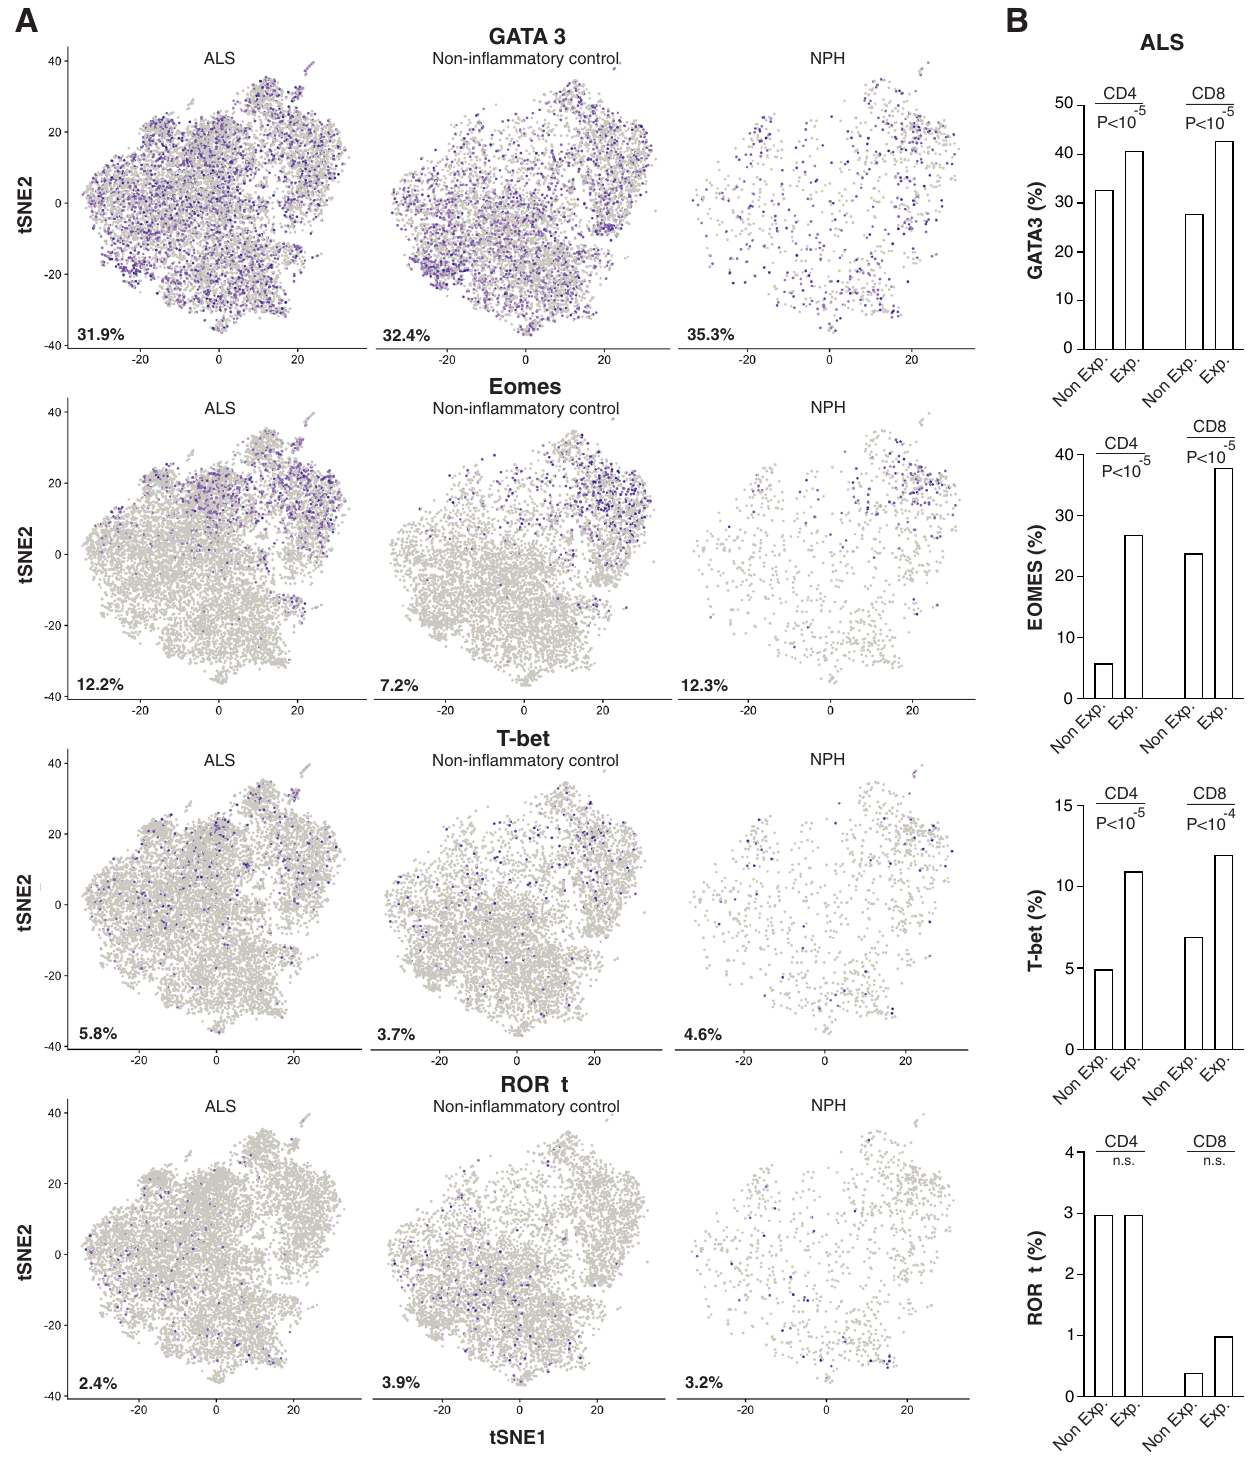
Fig. 5 | Distinct expression of lineage-de fi ning transcription factors among clonally expanded T cells in CSF of ALS patients. t-SNE plots of 10X scRNA-seq data showing expression of GATA3, Eomesodermin, Tbet, and ROR γ t with the percentage of positive cells (shown in purple) noted ( A ). Quanti fi cation of GATA3,